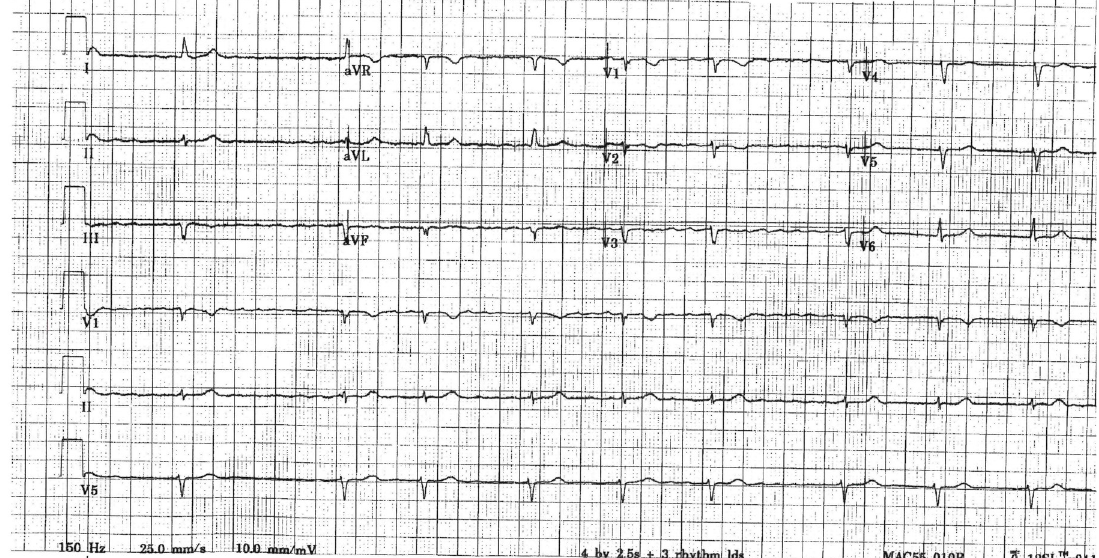
fibrillation with slow ventricular response and resolution of electrical discharges.